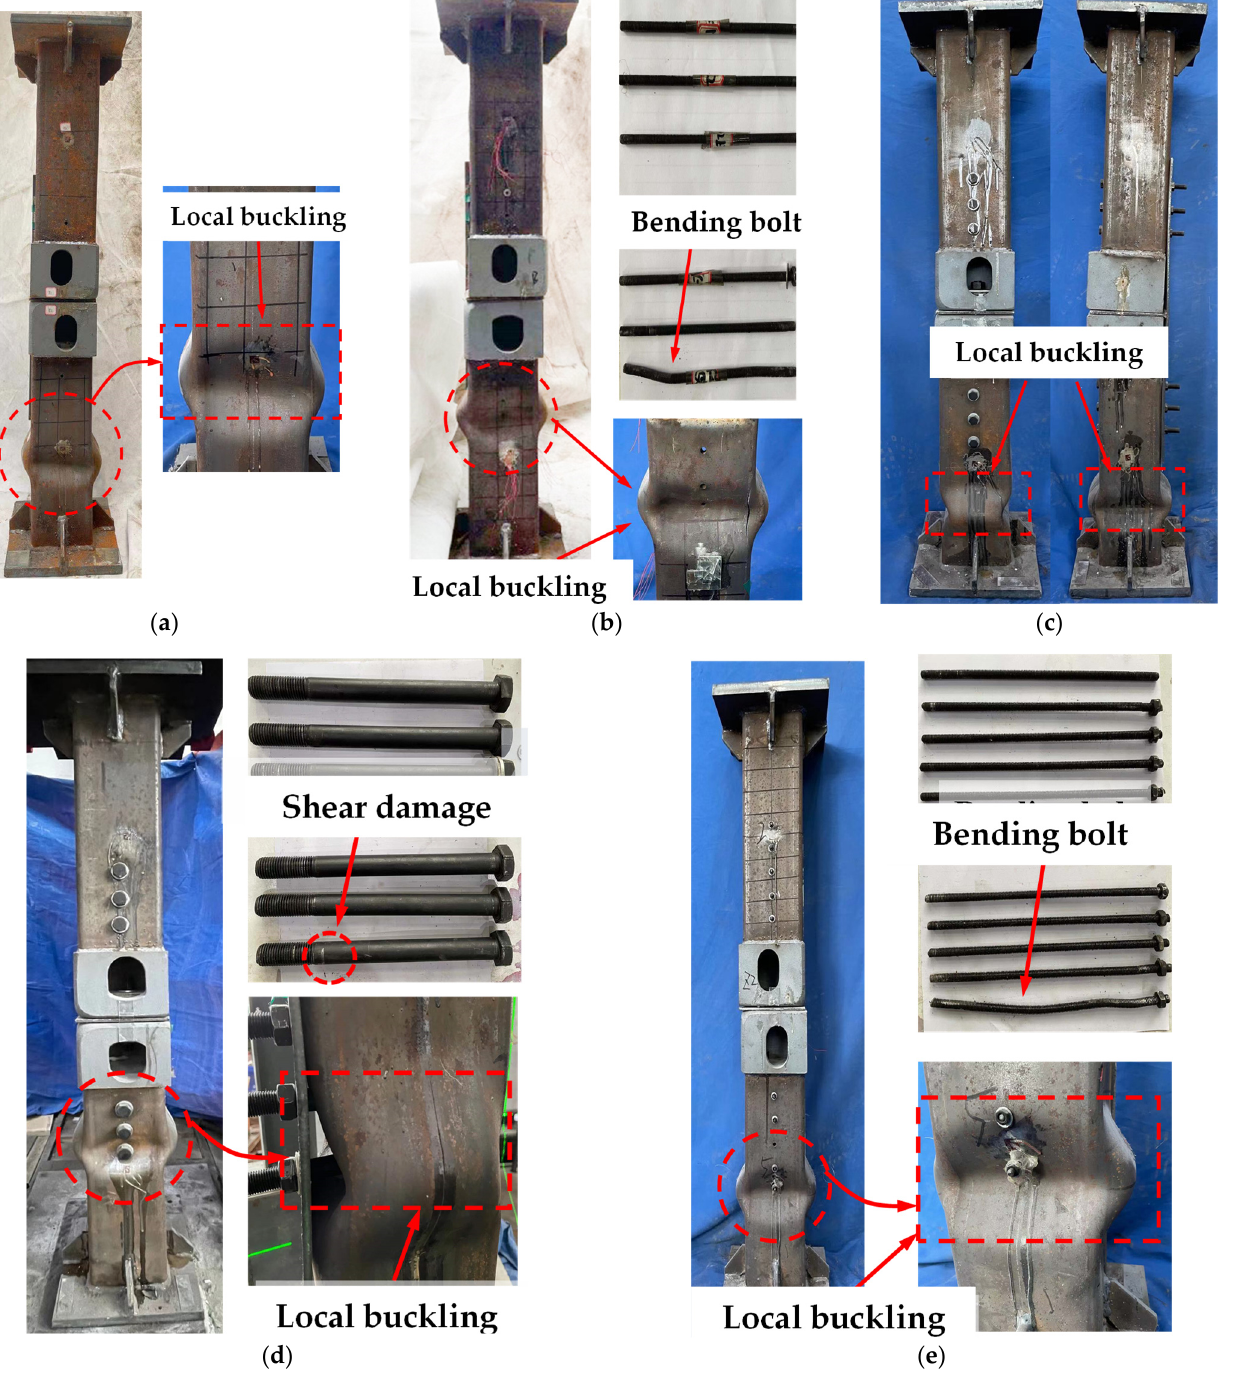
Figure 10. Failure mode of the specimens: ( a ) Specimen SC-1; ( b ) Specimen SC-2; ( c ) Specimen SC-3; ( d ) Specimen SC-4; and ( e ) Specimen SC-5.